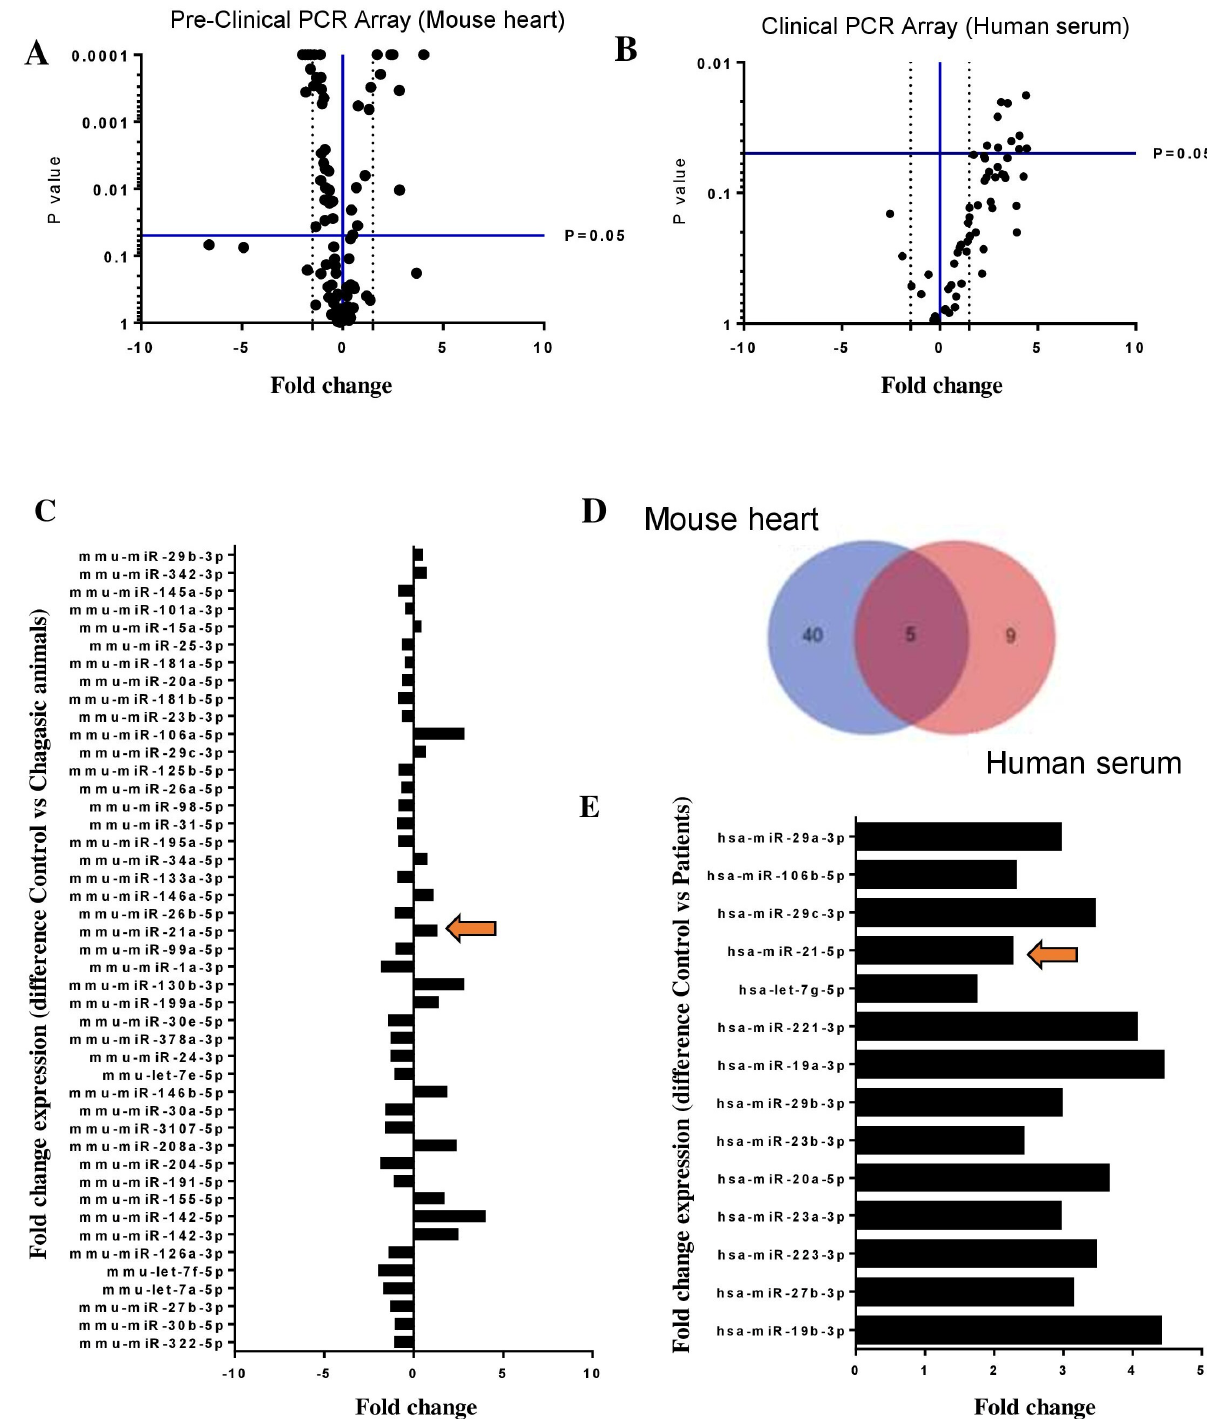
Figure 1. PCR array screening of selected miRNAs in Chagas disease. ( A ) Volcano plot of 88 miRNAs screened by PCR array in heart sample from chronic chagasic ( n = 8) versus naïve ( n = 4) mice ( B ) Volcano plot of 88 miRNAs screened by PCR array in serum samples obtained from chronic Chagas disease patients ( n = 7) compared with healthy subjects ( n = 3) ( C ) histogram of 45 deregulated miRNAs in heart sample from chronic chagasic ( D ) Venn diagram of PCR array showing five common miRNAs between human serum (pink) and mouse heart (blue) samples ( E ) histogram of 14 upregulated miRNAs in serum samples obtained from chronic Chagas disease patients. GenEX qPCR data analysis (Exiqon), p < 0.05; a cutoff value of 1.5-fold change-up and downregulated-was utilized in the analysis and miR-21 upregulation in both arrays is indicated by arrows.